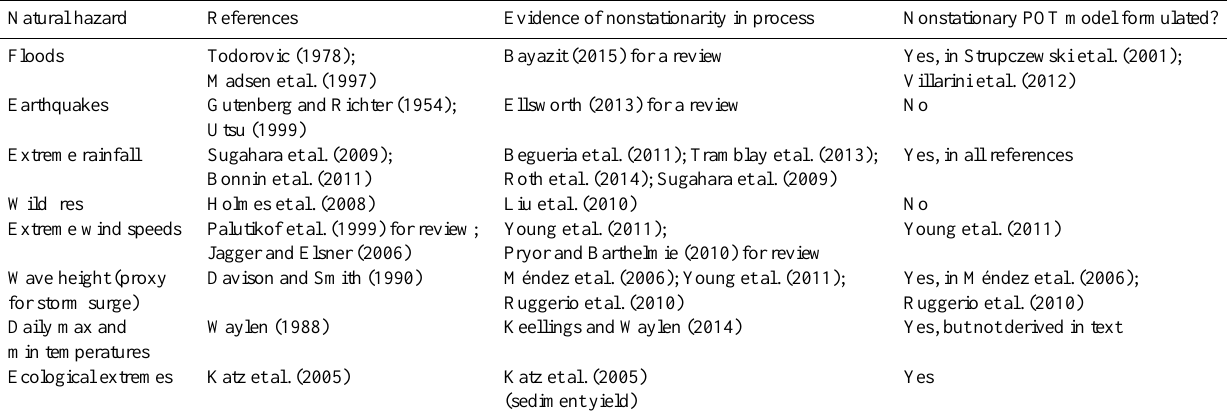
Table 1. Summary of natural hazards employing Poisson–GP model. Natural